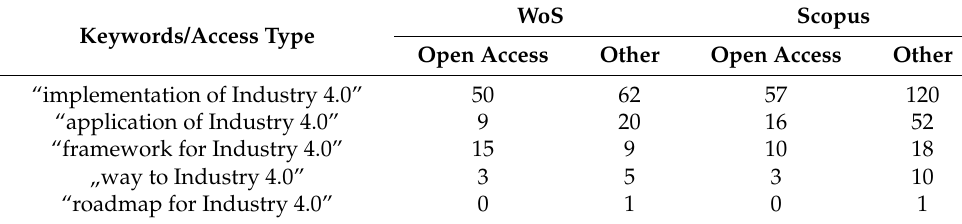
Table 2. Results of own literature review in the field: access type.